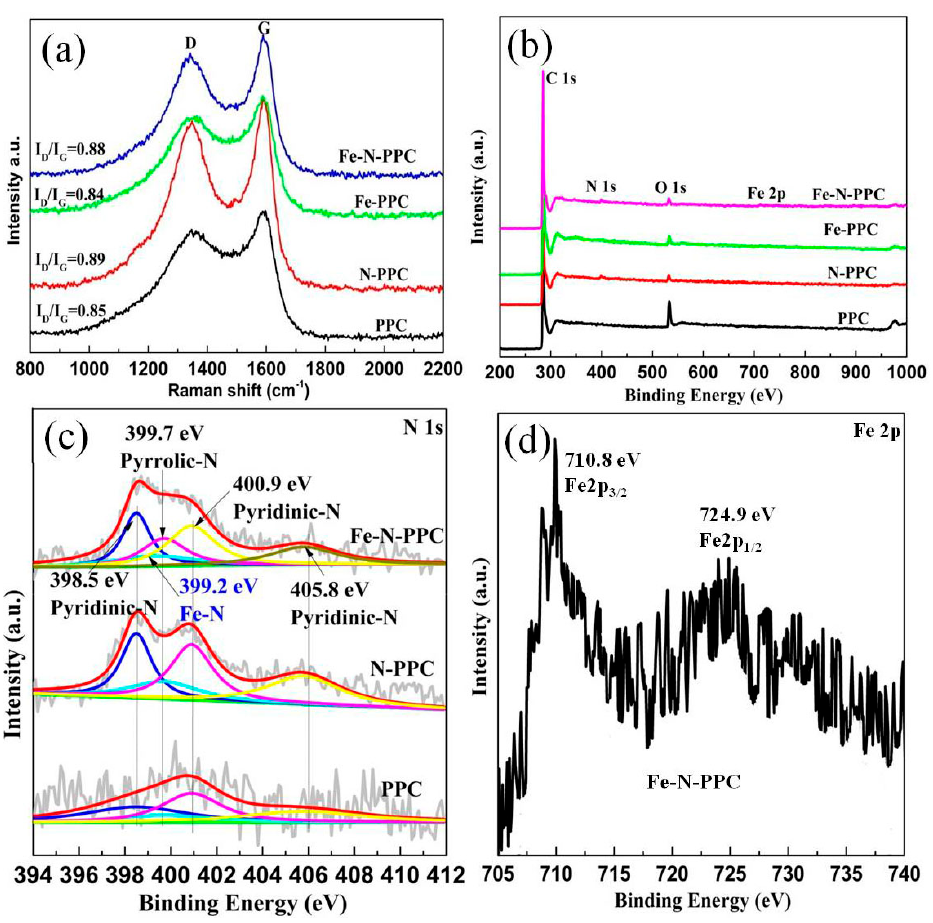
Figure 2. ( a ) Raman spectra and ( b ) High-resolution X-ray photoelectron spectroscopy (XPS) spectra of PPC, N-PPC, Fe-PPC, and Fe-N-PPC; ( c ) N 1s spectra of PPC, N-PPC and Fe-N-PPC; ( d ) Fe 2p spectra of Fe-N-PPC.